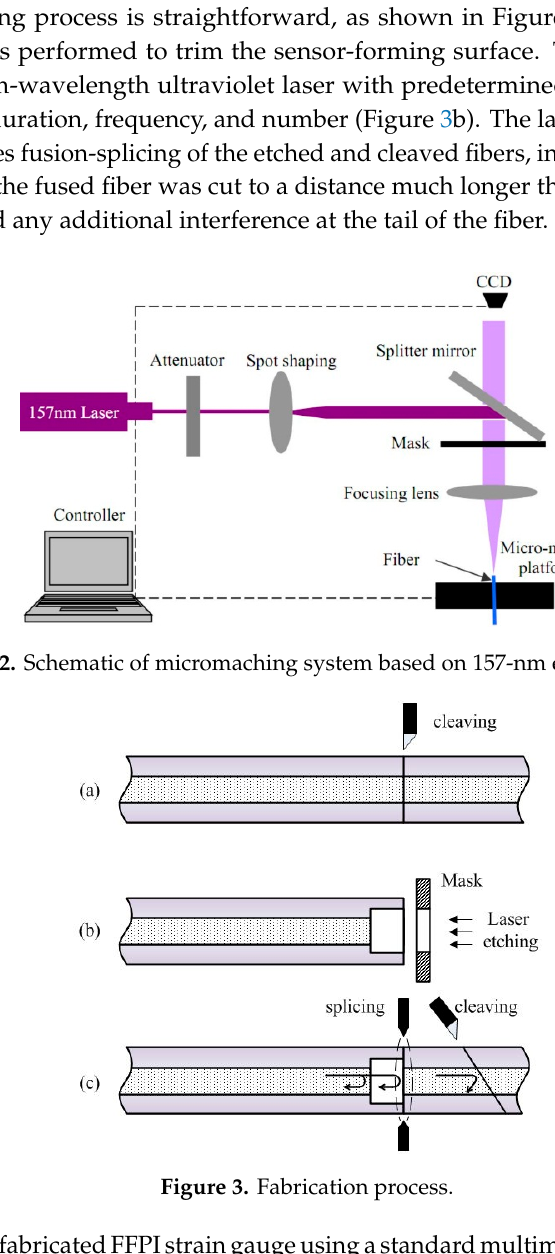
Figure 4. ( a ) Optical microscope photo of an FFPI strain gauge, and ( b ) cross-section view of the laser- etched Fabry–Pérot (FP) cavity.